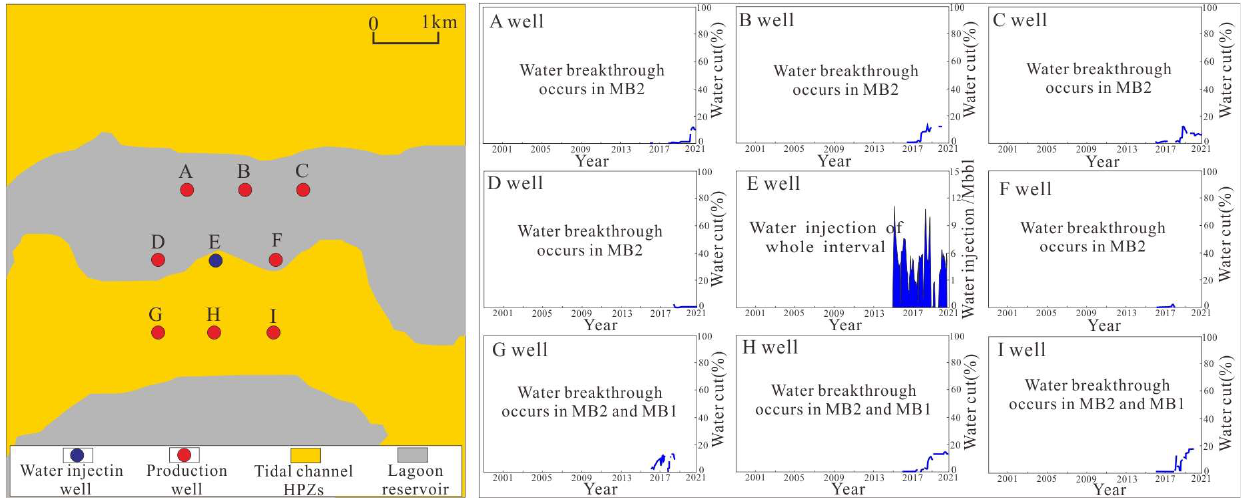
Figure 11. Connectivity of injection-production well pattern in the Mishrif Formation in X Oilfield.